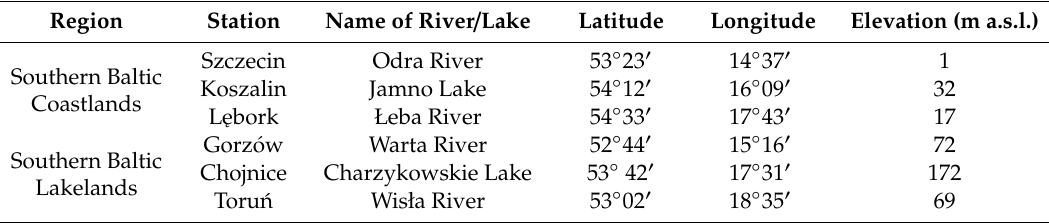
Table 1. Geographic position of weather stations [43,44].